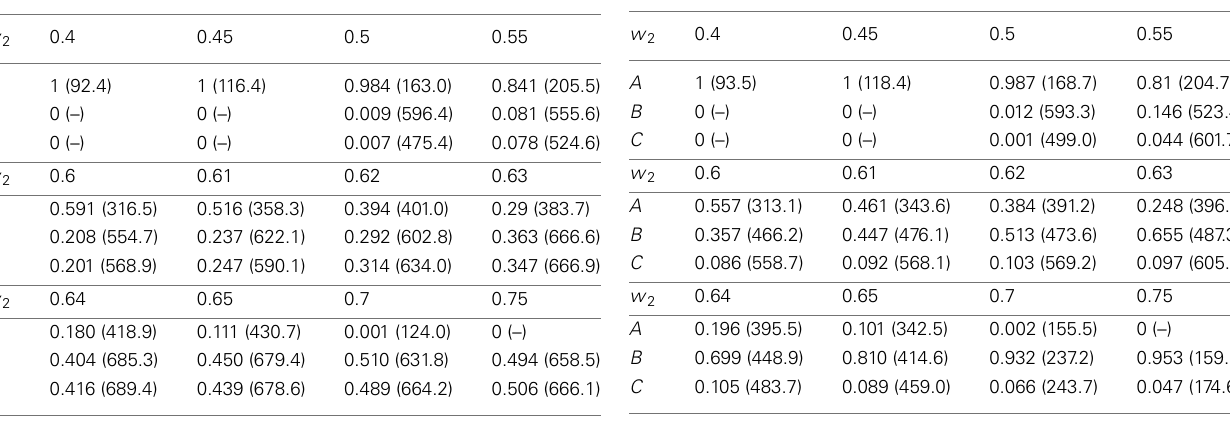
Table 2 | Relative number of choices and mean response times (arbitrary unit, in parentheses) for alternatives A = (9, 1), B = (1, 9),